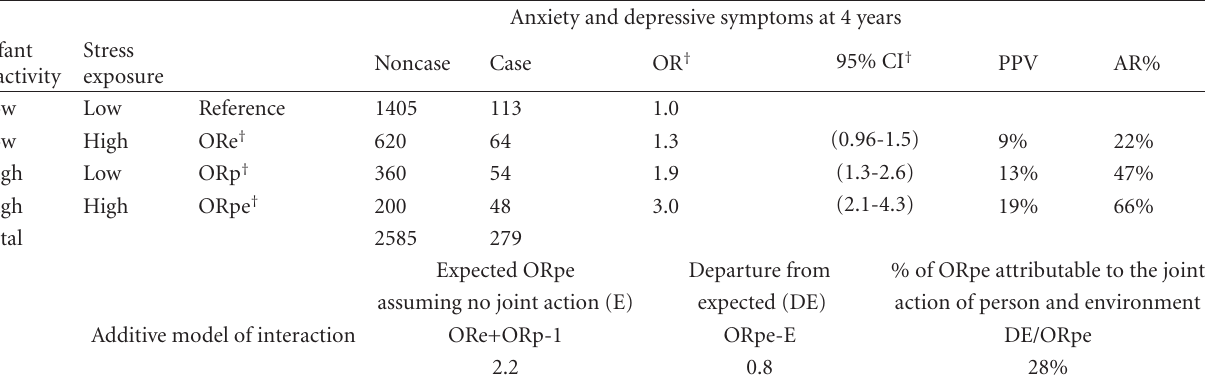
Table 3: Odds ratios for anxiety and depressive symptoms at age 4 years attributable to person-environment interaction between early life stress and reactive temperament style.